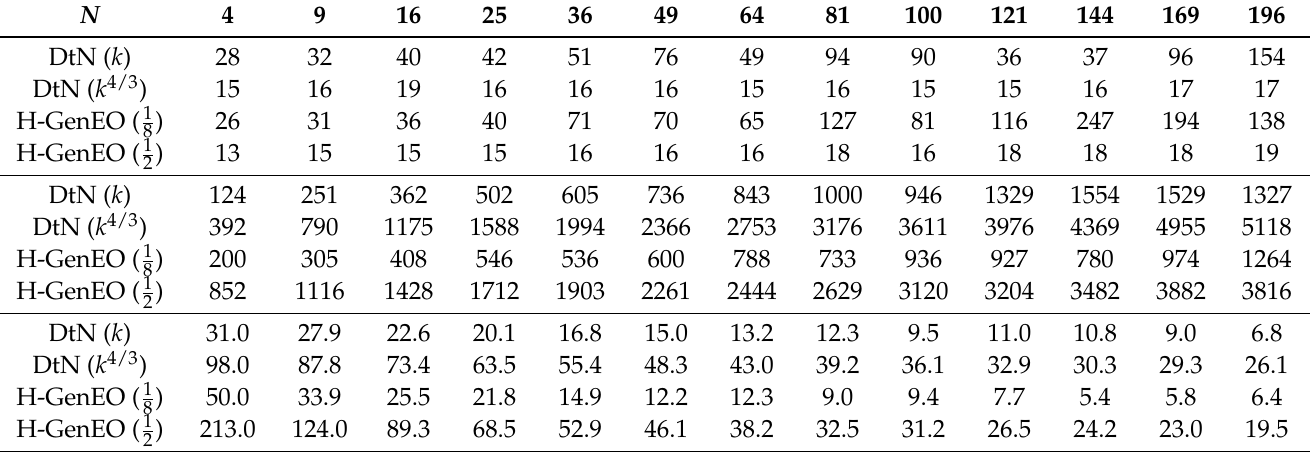
Table 3. Preconditioned GMRES iteration counts (above), size of coarse space (middle), and average number of eigenvectors taken per subdomain (below) for the homogeneous problem when using ORAS with the DtN and H-GenEO coarse spaces and a varying number of subdomains N for k = 73.8 √ √ N × N square subdomains is and h − 1 = 800. A uniform decomposition into